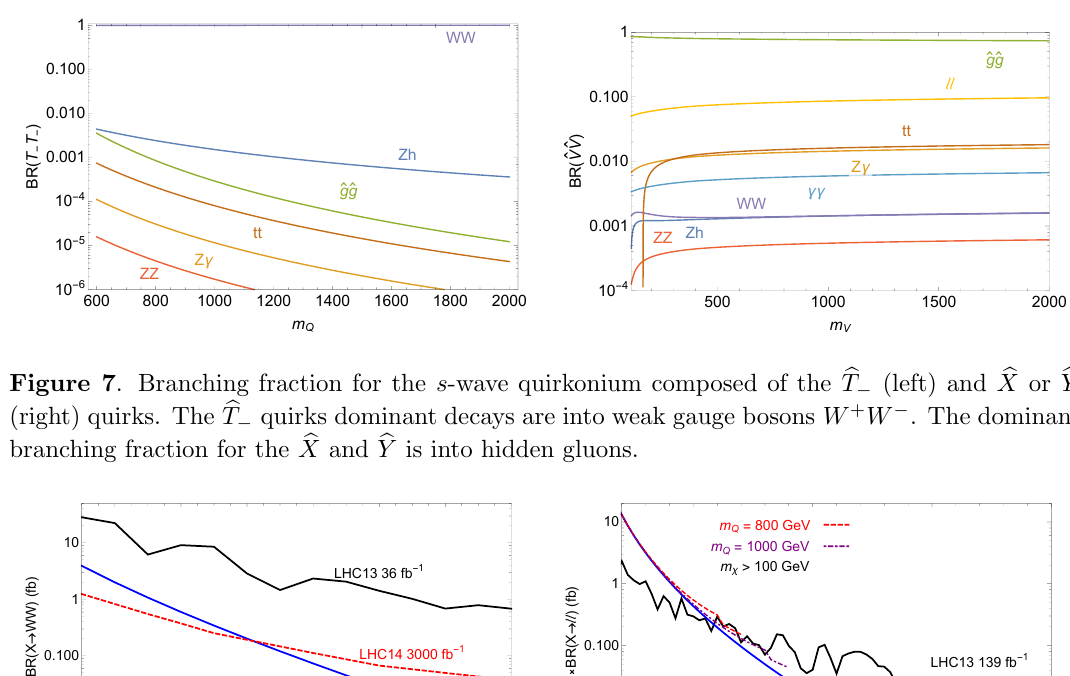
Figure 8 . Left: comparison of LHC 13 reach in W + W (cid:0) resonance searches for a (black) to the theoretical 14 TeV prediction (blue) and expected sensitivity of the high luminosity run (dashed red). Right: comparison of LHC 13 reach in dilepton resonance searches for Y Y bound states (black) to the theoretical 13 TeV prediction (blue). Contributions from included for m Q = 800 (1000) GeV in red dashed (purple dash-dotted) curve for DM masses greater b b than 100